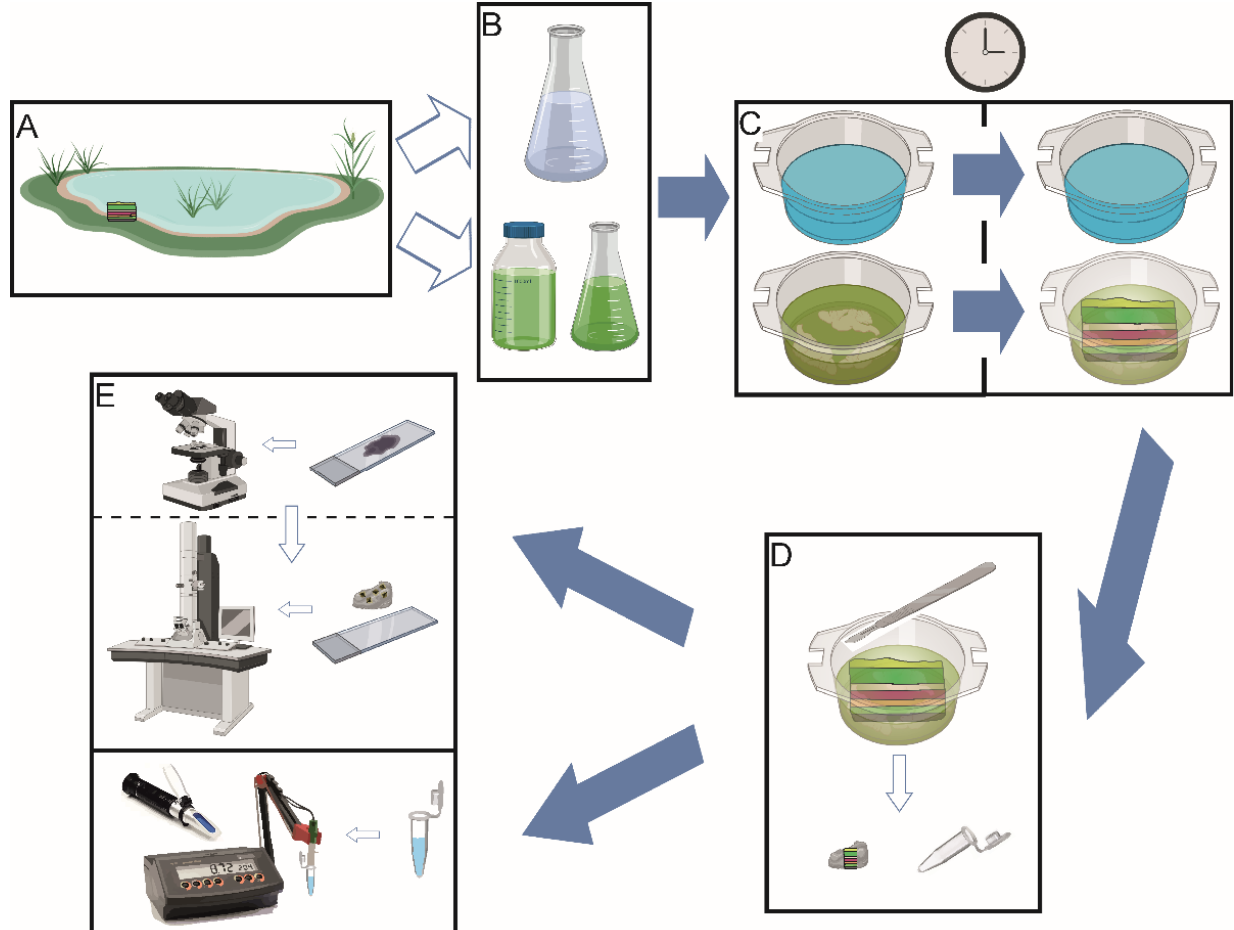
Figure 2. Flow chart of the experimental design. ( A ) Sampling collection from pond edges (selected areas of the salt flats). ( B ) Two types of samples collected: water samples (blue flask) and microbial mats (green flask and green bottle). ( C ) Incubations using microbial mats (green) and controls (blue) evolving through time and growing biomass (green). ( D ) Subsampling of water from incubations and controls (Eppendorf) and microbial mats/minerals (fragment). ( E ) Observations of microbial mats/minerals under optical microscopy ( upper ) and electron microscopy (middle), as well as salinity/pH determinations ( lower ).